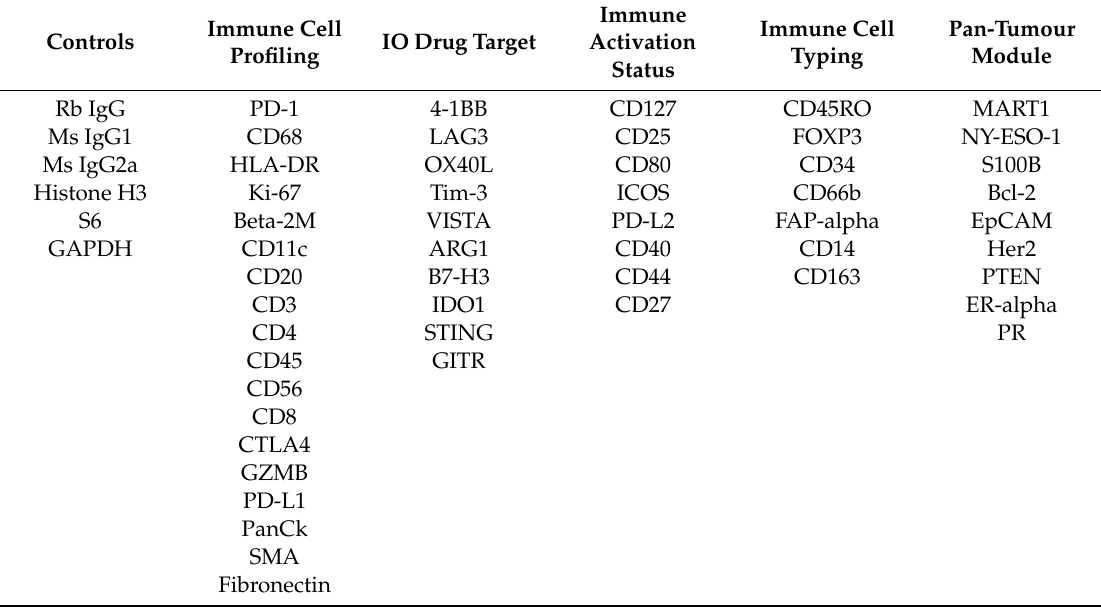
Table 1. Target proteins within Nanostring Digital Spatial Profiler (DSP)